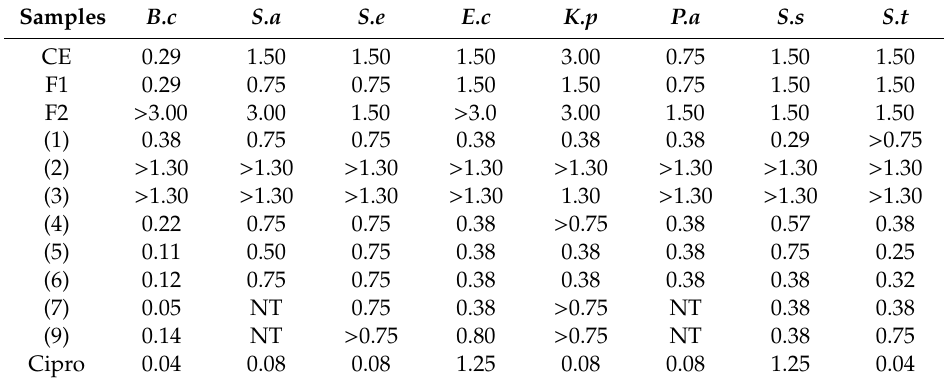
B.c : Bacillus cereus (ATCC 11778), S.a : Staphylococcus aureus (ATCC 25923), S.e : Staphylococcus epidermidis (ATCC 12223), E.c : Escherichia coli (ATCC 8739), K.p : Klebsiella pneumoniae (ATCC 13883), P.a : Pseudomonas aeruginosa